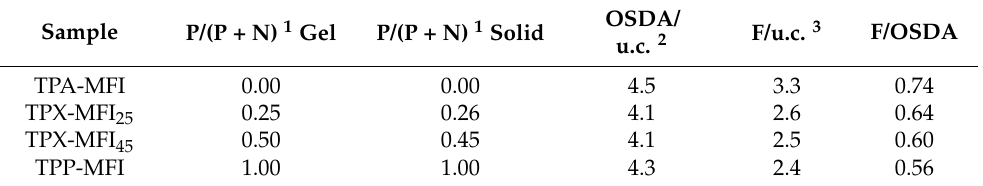
Table 2. Chemical composition of the silicalite-1 samples prepared using TPA, TPP, and mixtures of them as